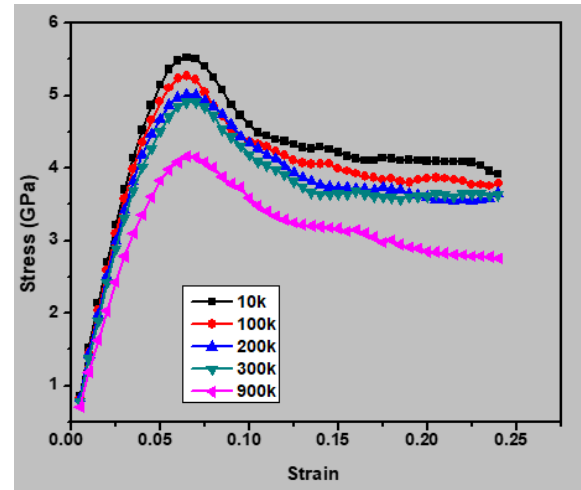
Figure 10. Stress–true strain curves for the nanocrystalline austenitic stainless steel sample with an average grain size of 2.5 nm at various temperatures.